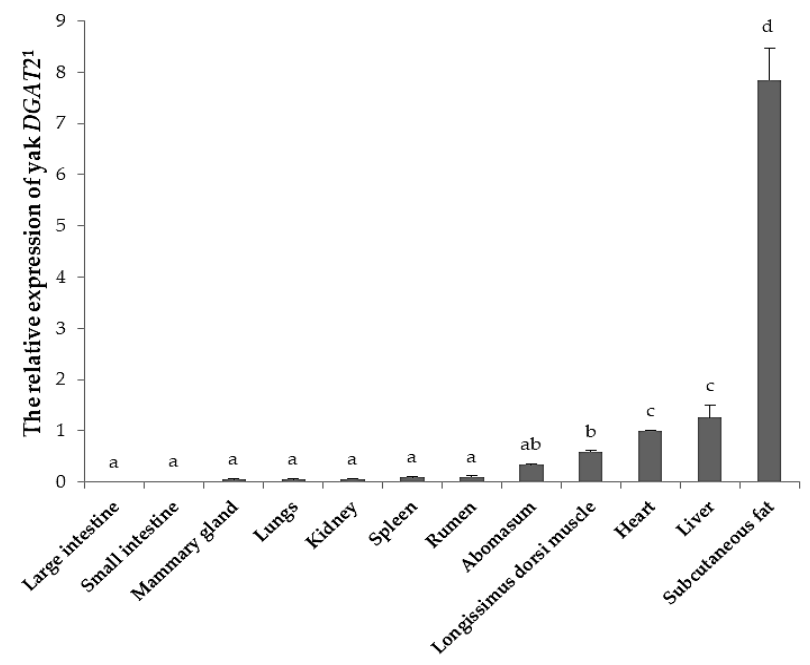
Figure 2. The relative expression of DGAT2 in twelve tissues of yak. 1 Heart represents control tissue. Error bars indicates standard deviation. The different lower-case letters on columns indicate significant difference ( p <